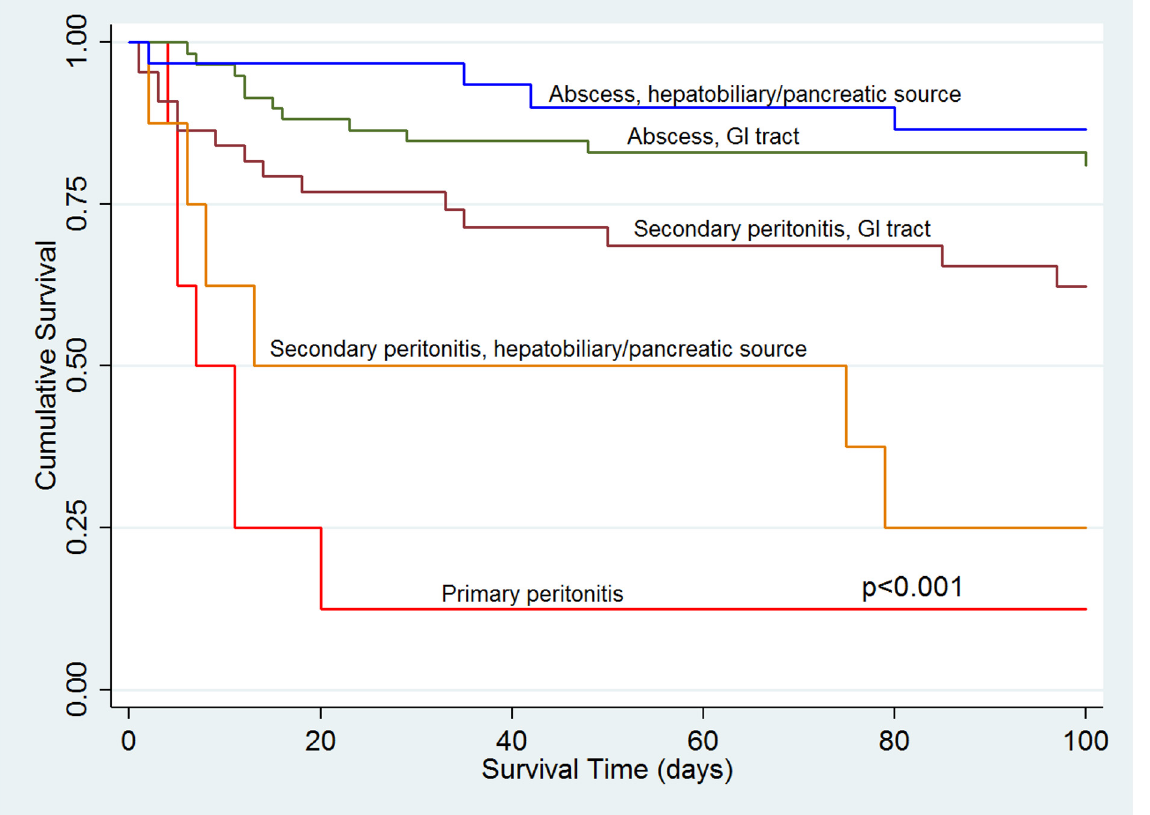
Fig 1. Survival analysis by type of intra-abdominal